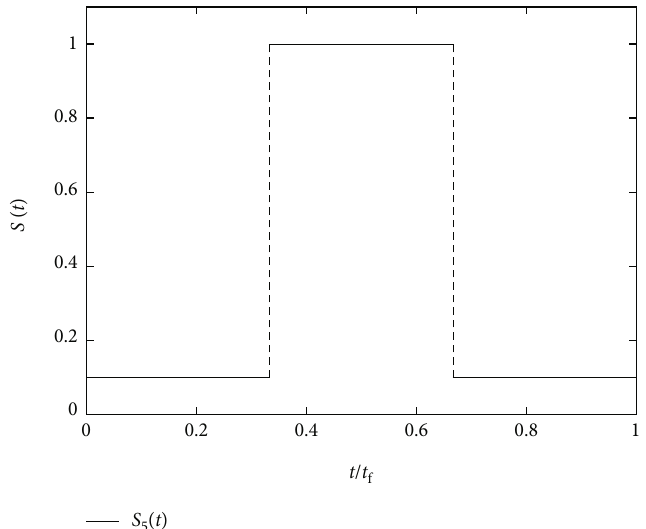
ð 0 Þ = 20 ° , γ = − 70 ° . m f